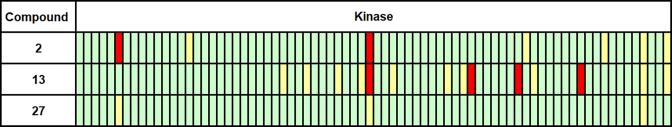
Kinase selectivity data for representative imidazopyridines 2, 13 and 27 on screening against a human kinase panel at 1 µM concentration; green < 50% inhibition; yellow 50–90% inhibition; red > 90% inhibition.29